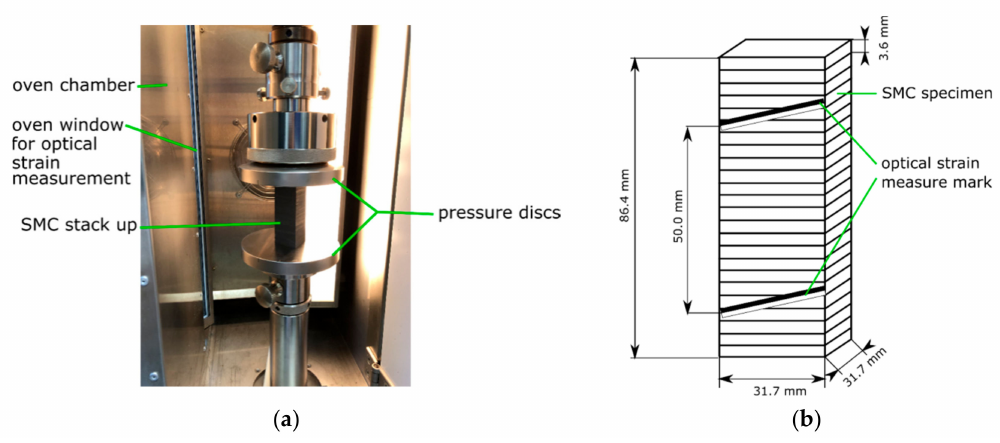
Figure 3. ( a ) C-SMC stackup between pressure discs in the universal testing machine; ( b ) C-SMC stackup in close-up